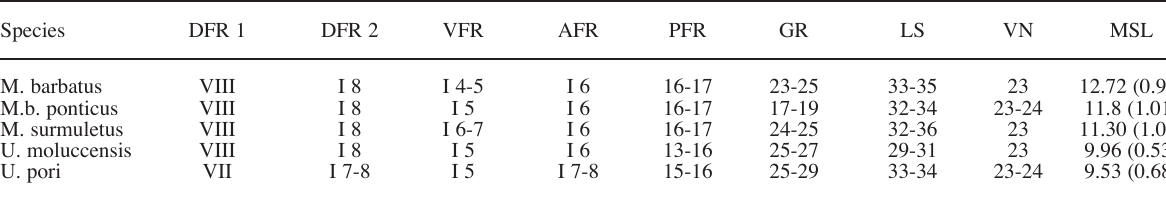
T ABLE 4. – Formula of observed meristic characters of the Mullidae species. Roman letters show spine rays. Standard deviations of mean standard length (MSL) are given in brackets. DFR1, first dorsal fin rays; DFR2, second dorsal fin rays; VFR, ventral fin rays; AFR, anal fin rays; PFR, pectoral fin rays; GR, gill rakers; LS, scales in a lateral line; VN, vertebra